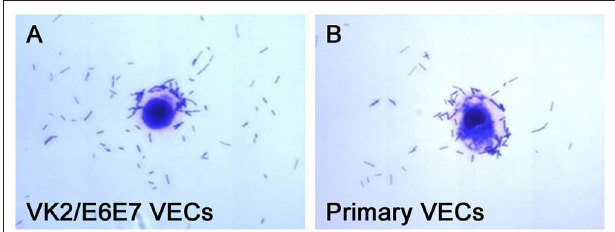
Frontiers in Medicine |